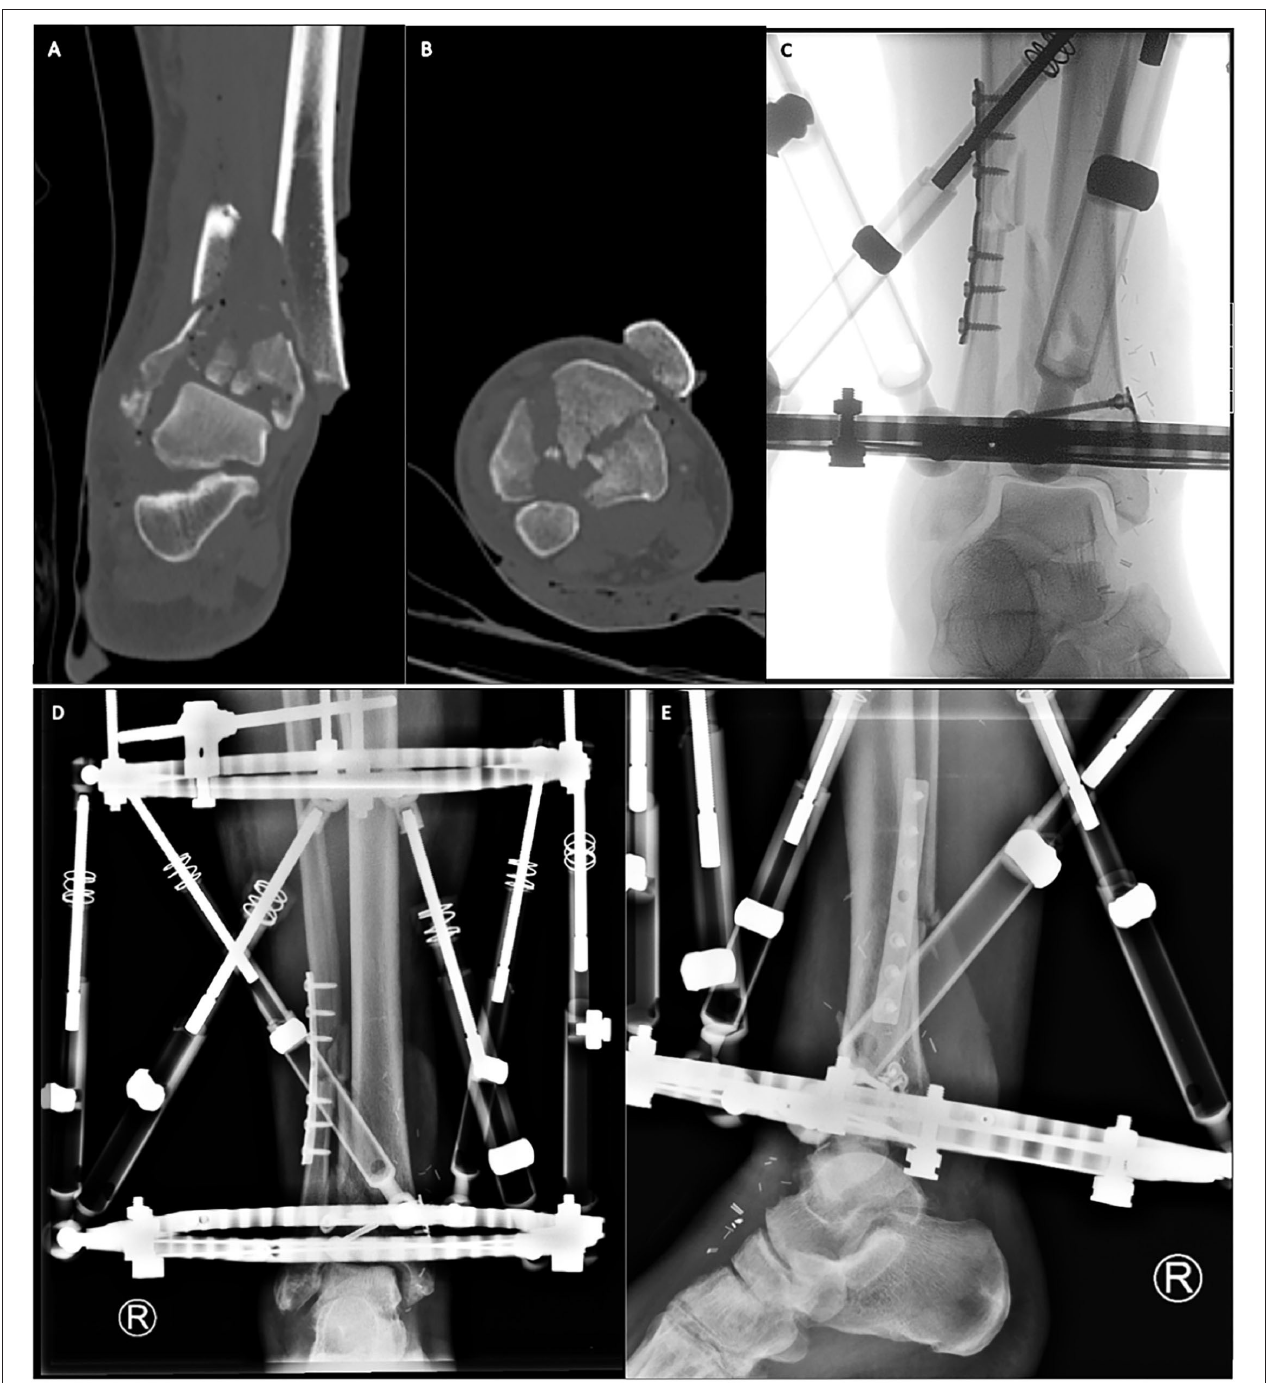
FIGURE 2 | Primary Hybrid external fixation in combination with plate and lag screw osteosynthesis in a ◦ II open tibial pilon fracture. We present a 55-year-old male, with a ◦ II open tibial pilon fracture AO type 43-C3, who presented via the trauma room. After emergency preoperative CT scans [ (A) coronal plane, (B) axial plane] temporary fixation and soft tissue conditioning was performed. The extensive soft tissue defect on the anteromedial side was covered with an arteria radialis microvascular free flap. Afterwards the comminuted fibula was restored in length and rotation and the articular surface of the tibial pilon was reconstructed using minimally invasive plating and lag screws [ (C) Intraoperative fluoroscopy]. Finally, we stabilized the tibial pilon fracture using a hybrid circular frame with tensioned K-wires in the distal fragments and Schanz-screws in the proximal tibia [ (D) Post-operative a.p. X-ray, (E) Post-operative lat. X-Ray].